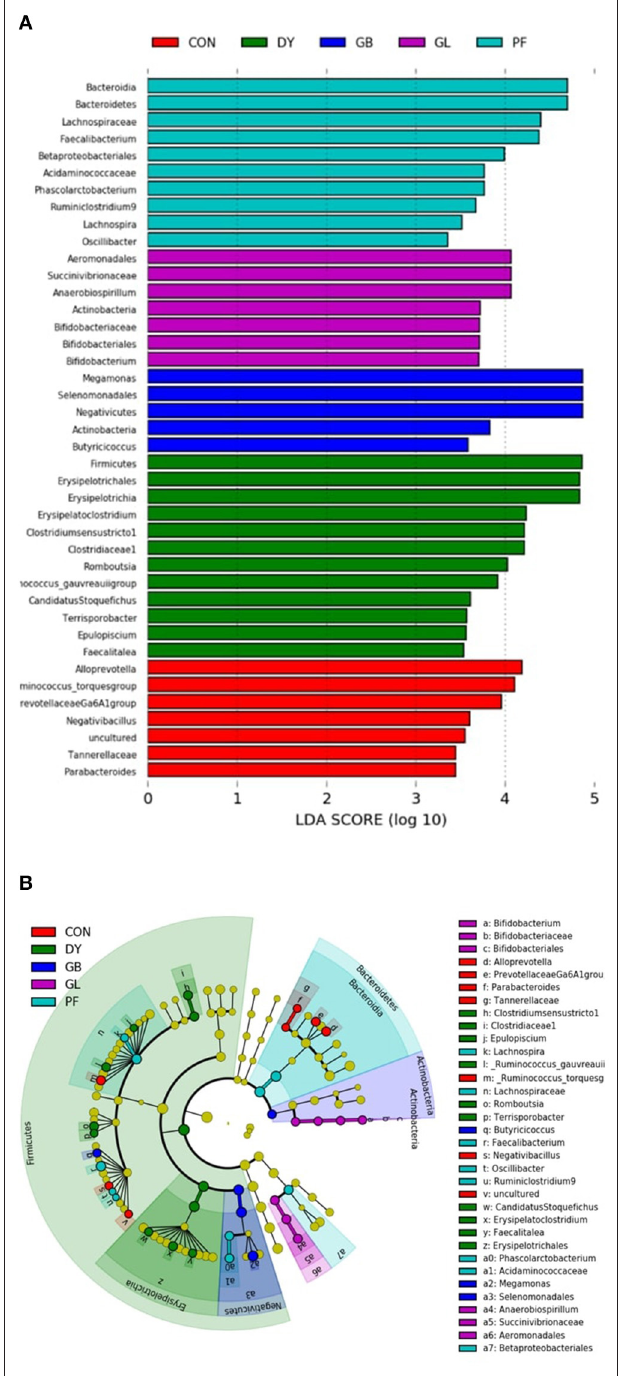
FIGURE 6 | Linear discriminant analysis (LDA; A ) effect size (LEfSe; B ) Analysis of fecal microbiota of dogs fed legumes or yeast as the primary protein sources. CON, Poultry by-product meal control; GBD, Garbanzo bean; GLD, Green lentil; PFD, Peanut flour; DYD, Dried yeast.